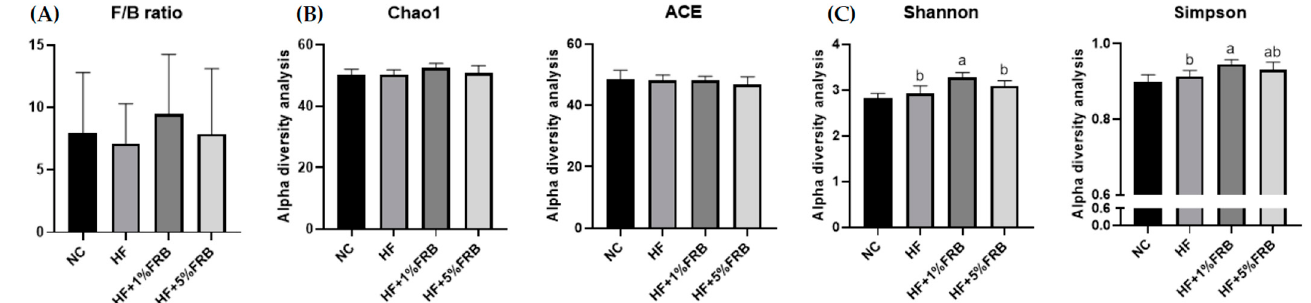
Figure 9. Effects of the water extract of fermented rice bran (FRB) on the Firmicutes-to-Bacteroidetes (F/B) ratio and α -diversity of the fecal microbiota in aged rats with high-fat (HF) diet feeding. ( A ) F/B ratio. ( B ) Community richness of the fecal microbiota. ( C ) Community diversity of the fecal microbiota. Values are presented as the mean ± standard deviation ( n = 5). * p < 0.05 vs. the normal control (NC) group; significance between two groups was determined using Student’s t -test. In the HF diet-fed groups, different letters indicate significant differences between groups at p < 0.05 by a one-way ANOVA with Fisher’s post hoc test.